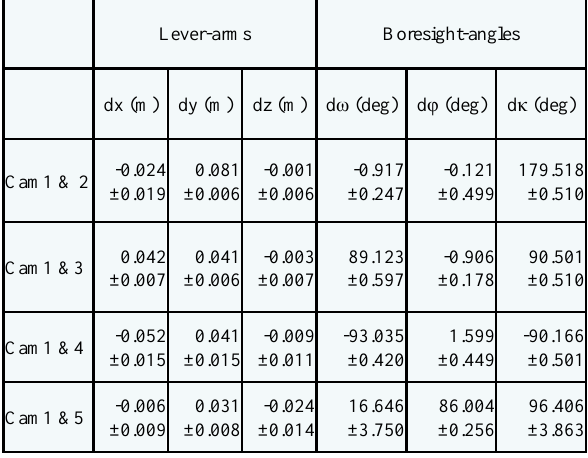
Table 3. Estimated lever-arms and boresight-angles Lever-arms Boresight-angles